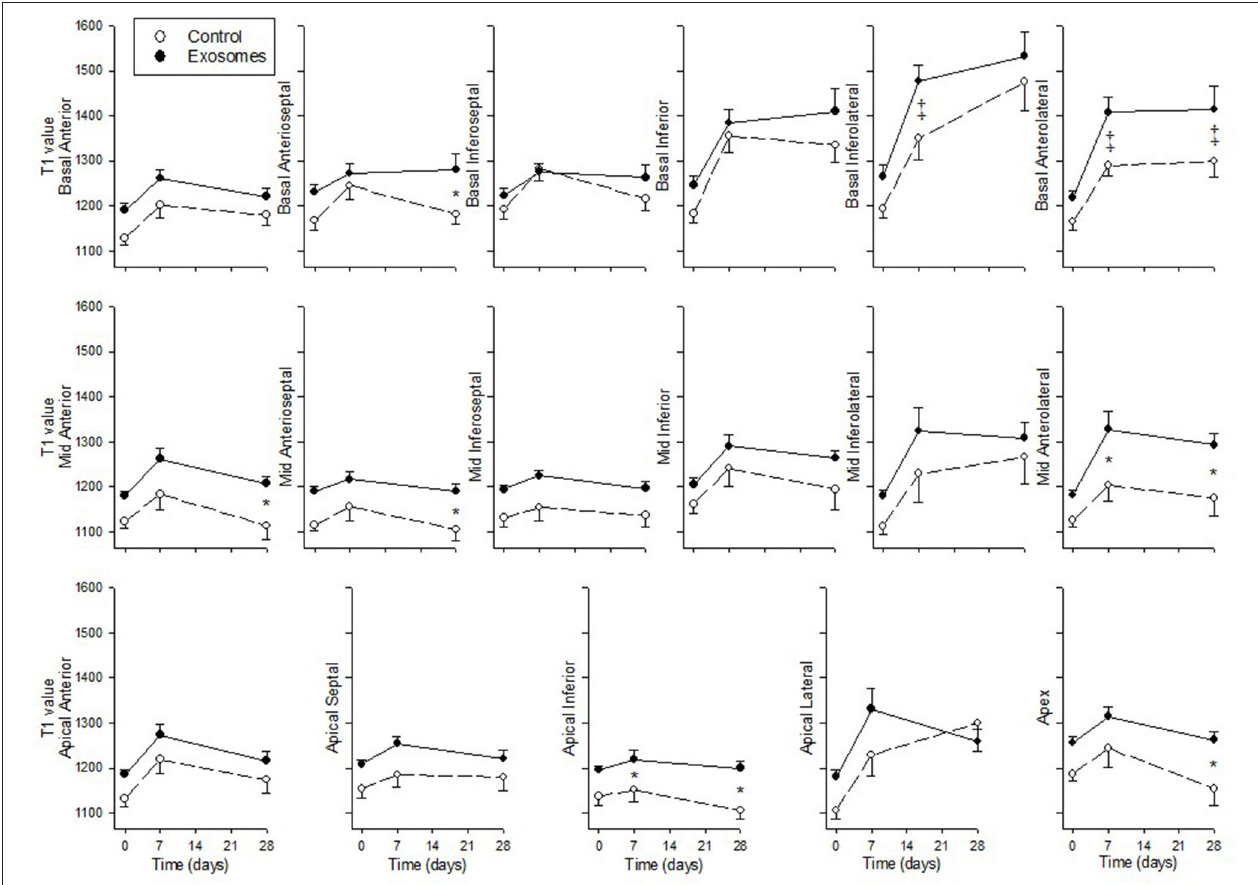
FIGURE 7 | Serial cardiac MRI T1 MOLLI values across 17 segments in ten pigs receiving 7 days intravenous administration of exosomes (•) following MI and ten pigs vehicle control ( ◦ ) treated pigs. Values shown are mean ± SEM. Significant differences at time-matched points between the exosomes and control pigs are indicated as follows: * p < 0.05 and ‡ p <